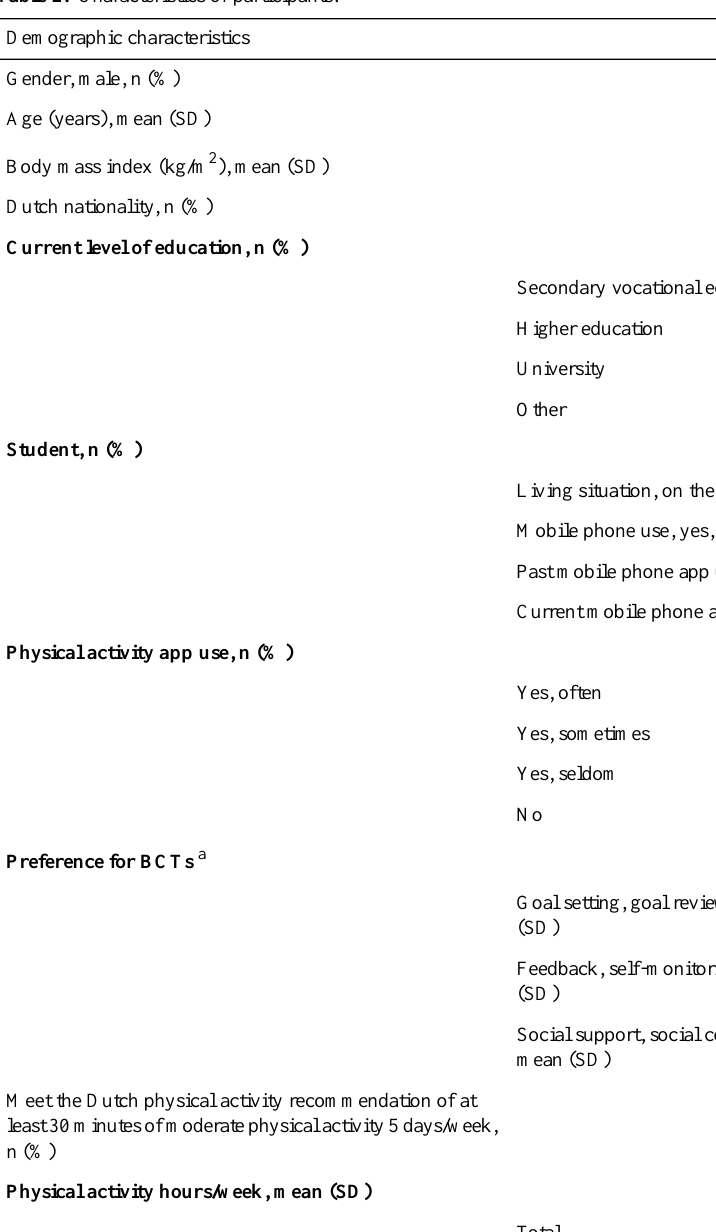
Table 2. Characteristics of